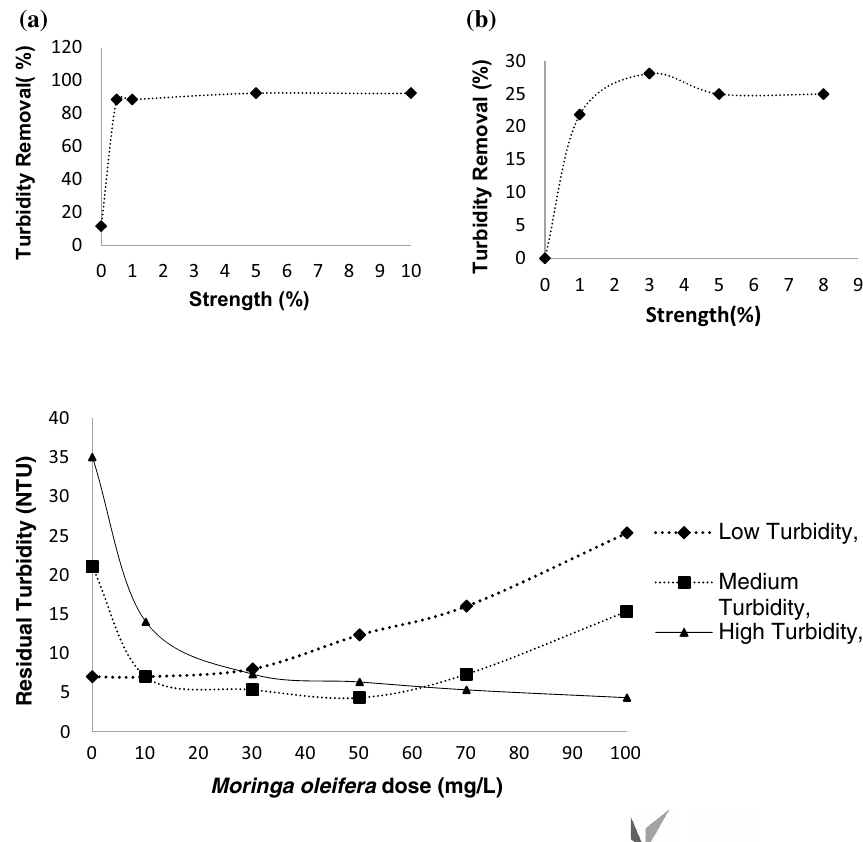
Fig. 3 Effect of strength of a Moringa oleifera extract and b Aloe Vera extract on turbidity removal